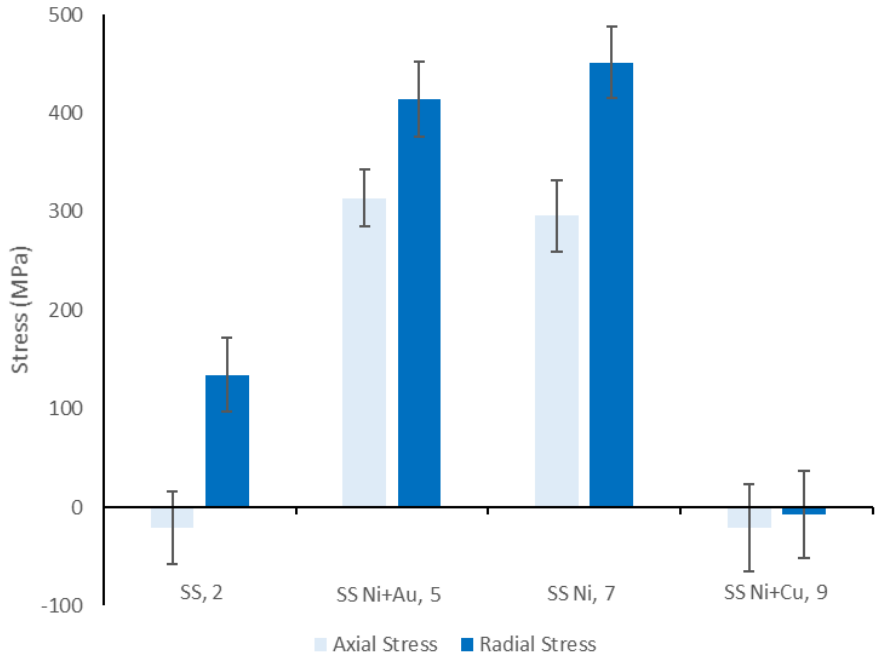
Figure 14. Coated samples FIB ring − core analysis results compared to the uncoated sample mean.